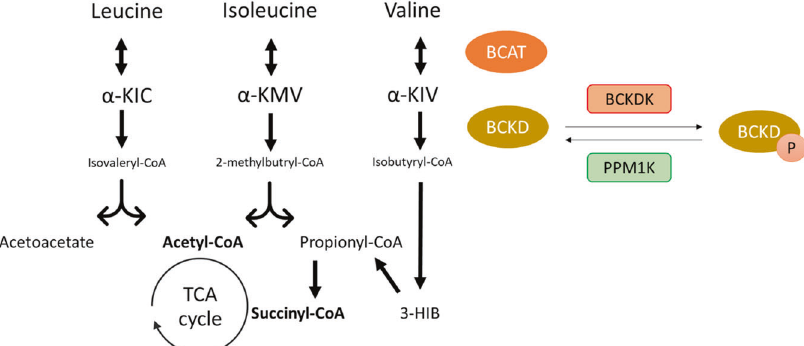
Fig. 1 Schematic overview of BCAA catabolism. BCAT branched-chain amino acid transaminase, BCKD branched-chain keto acid dehydrogenase, α -KIC α -ketoisocaproate, α -KMV α -keto-methylvalerate, α -KIV α -ketoisovalerate, 3-HIB 3-hydroxyisobutyrate, BCKDK BCKDK kinase, PPM1K BCKDK phosphatase. Adapted from Neinast et al.